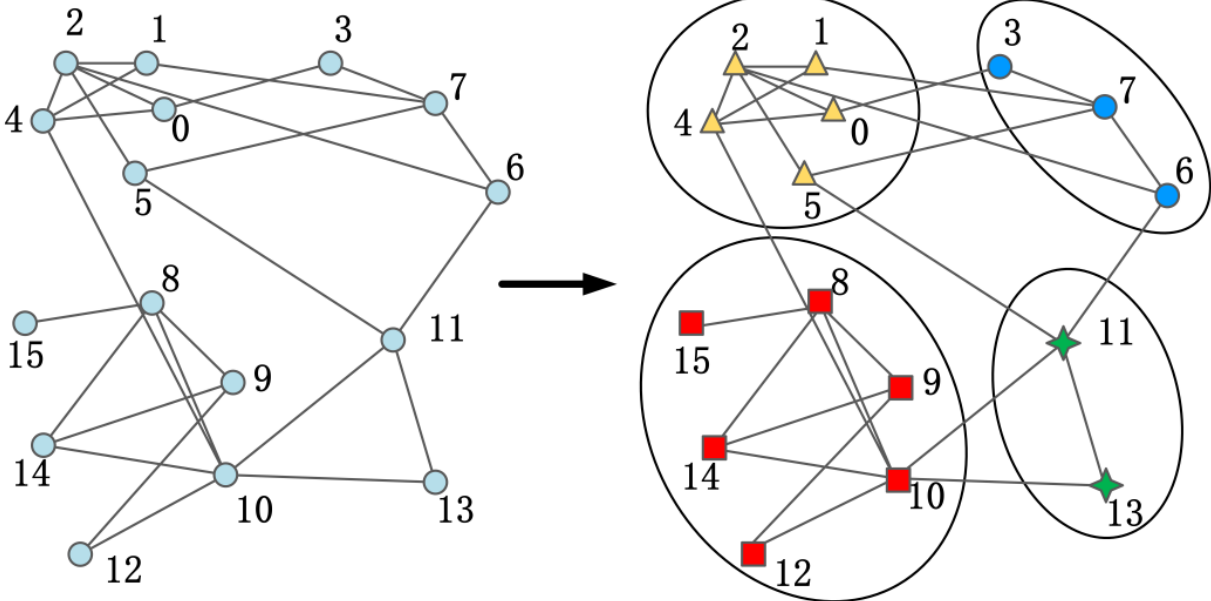
Figure 3. Louvain algorithm clustering visualization. Different numbers represent different fea- tures.